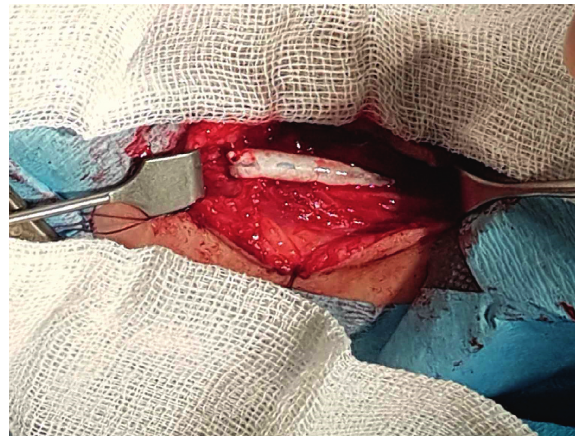
Figure 5: Aneurysm of the brachial artery resected with PTFE graft implantation.